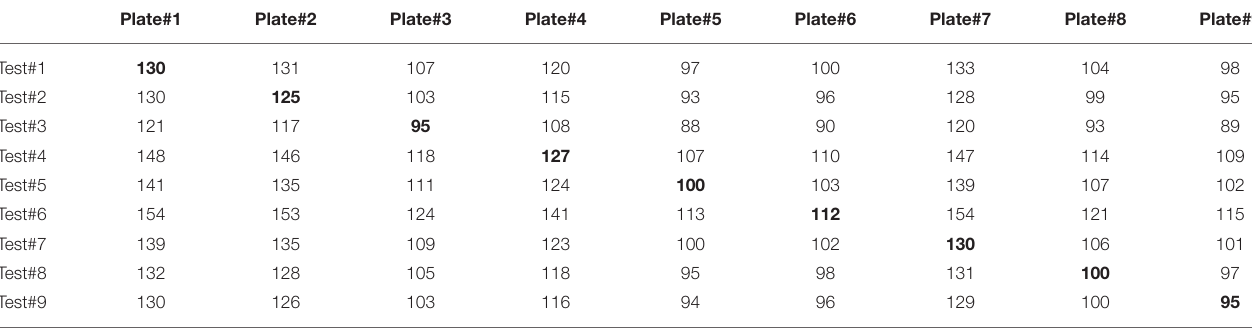
TABLE 1 | Comparison of measured (ground truth) and estimated plate radii for Subject